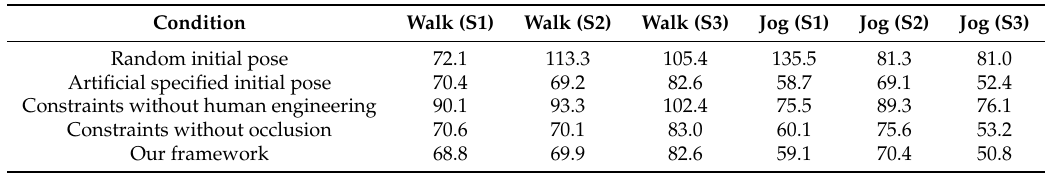
Table 3. The reconstruction RMS errors on different conditions by changing the initial spatial pose or reducing the